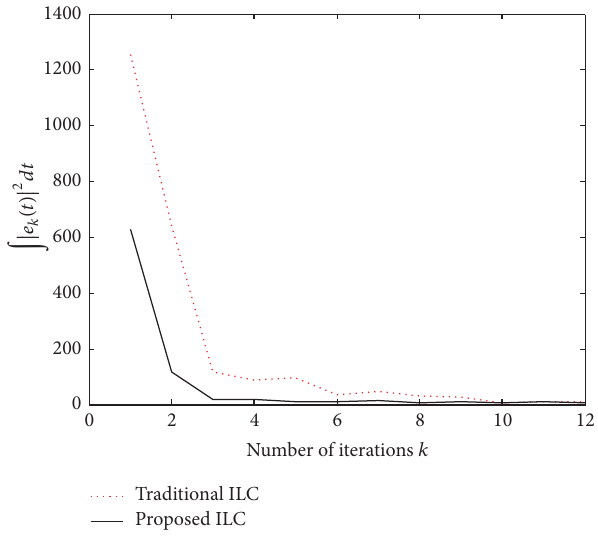
Figure 2: Comparison of tracking